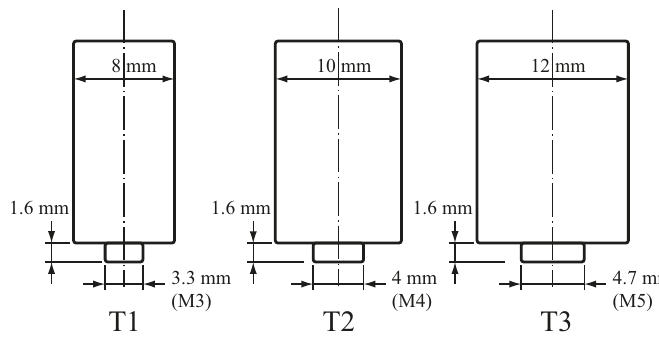
Figure 3. Schematic plots of three weld tools for weld radii of 4, 5, and 6 mm, denoted as T1, T2 and T3 tools, respectively.